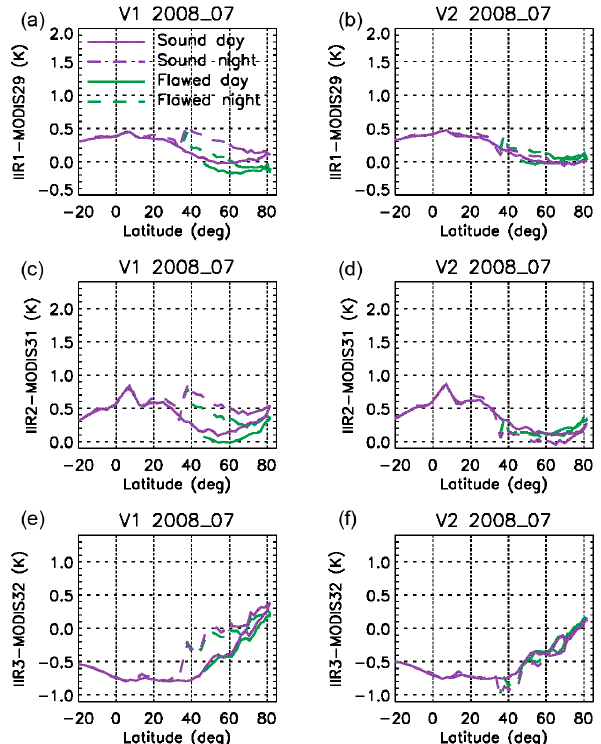
Figure 13. Median IIR–MODIS C5 BTDs vs. latitude under clear- sky conditions over oceans in July 2008 for IIR Version 1 (a, c, e) and Version 2 (b, d, f) . (a, b) IIR1–MODIS29; (c, d) IIR2– MODIS31; (e, f) IIR3–MODIS32. Purple: sound rows; green: flawed rows. Solid: day; dashed: night.